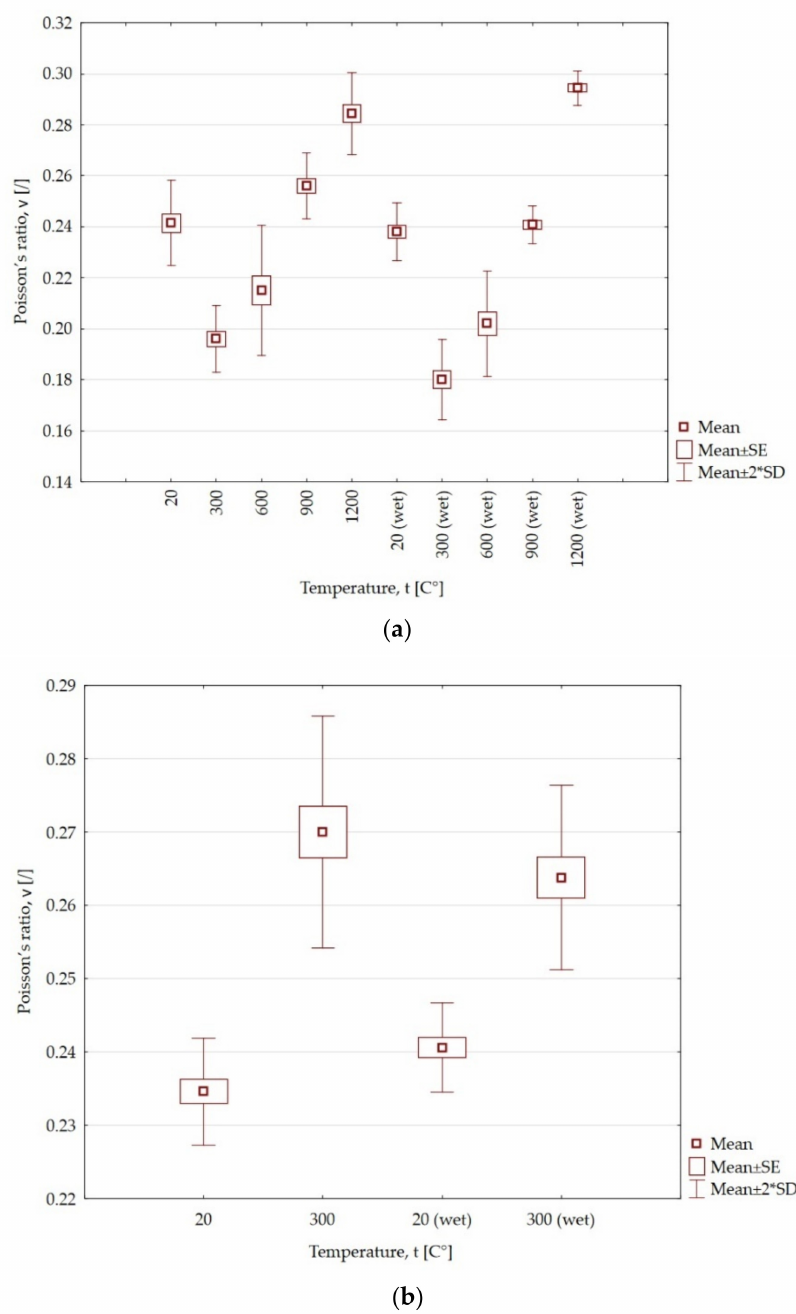
Figure 8. The influence of high temperatures on changes in Poisson’s ratio: ( a ) sandstone; ( b ) claystone; SE—standard error; SD—standard